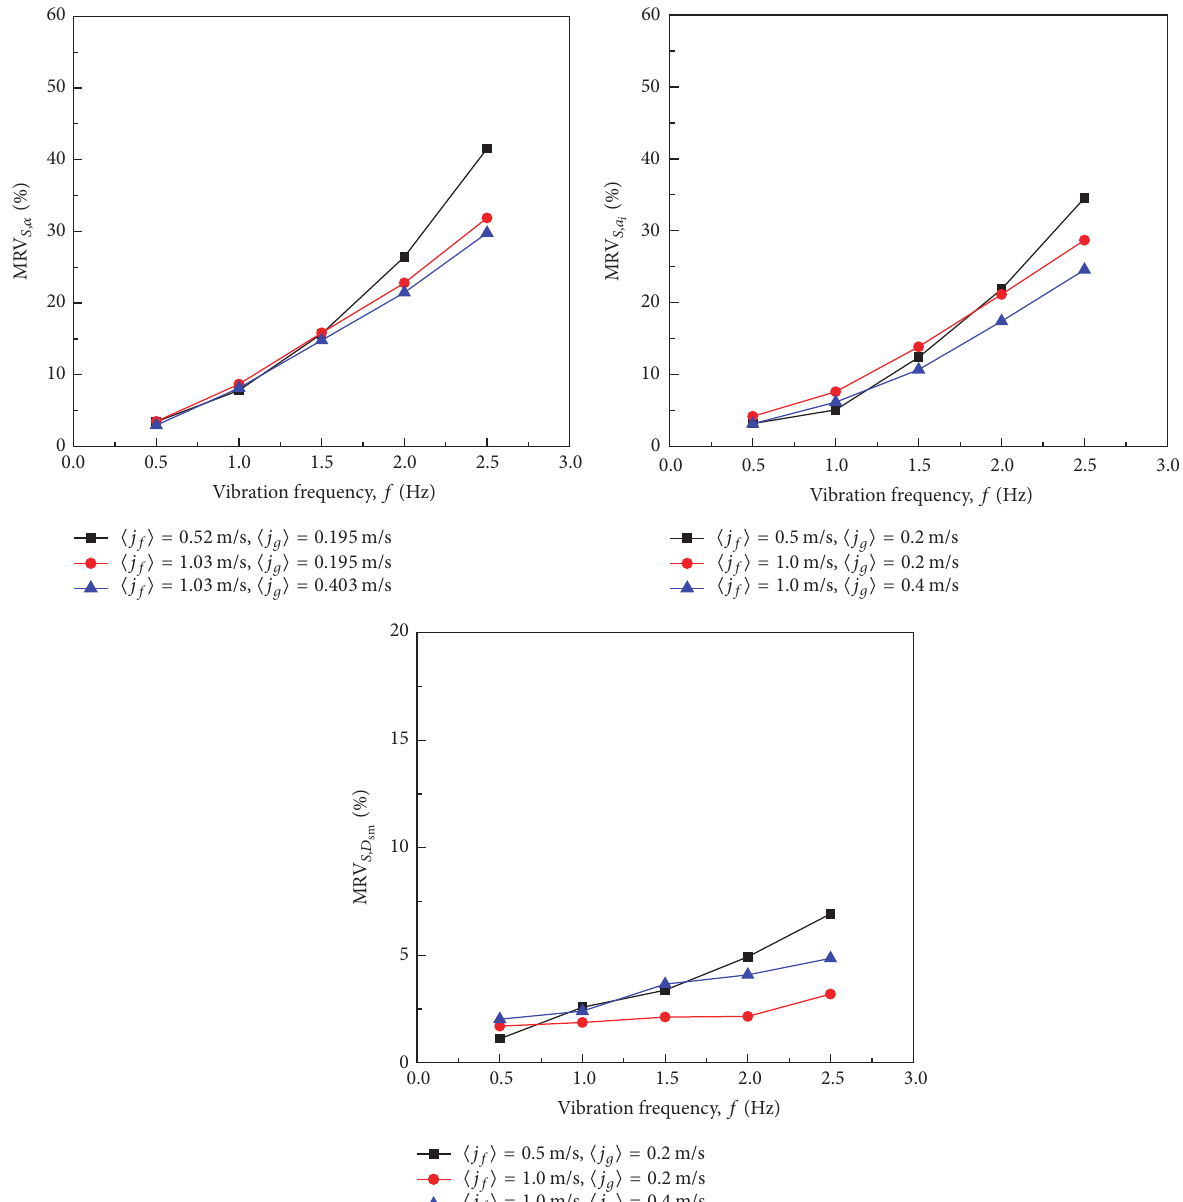
Figure 9: Vibration frequency effect on MRV 𝑆 of local flow